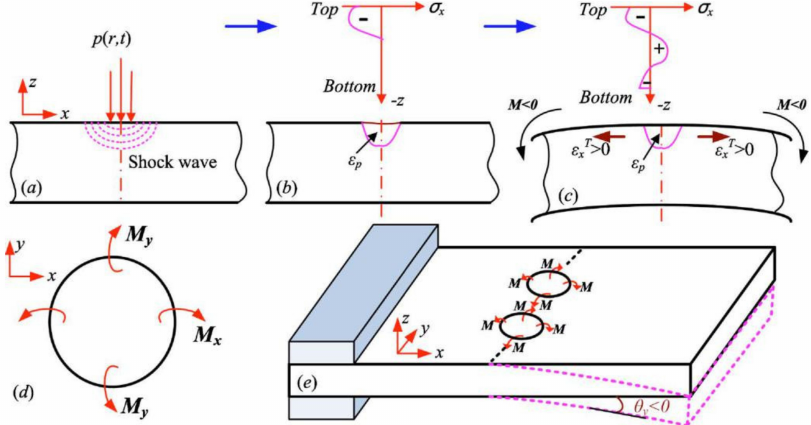
Figure 6. The stress gradient mechanism (SGM) of LSF: ( a ) LSP loading; ( b ) generation of stress gradient; ( c ) relaxation of stress gradient and bending; ( d ) bending moment on the cell and ( e ) bending of metal sheet with one end fixed [46].